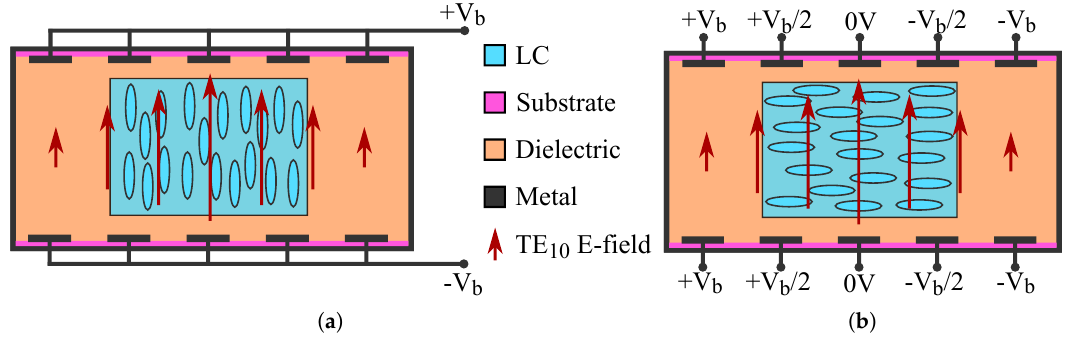
Figure 4. Cross section of an LC waveguide phase shifter, as presented in [16,17]. The waveguide is filled with a dielectric which is utilized as an LC cavity. For electric LC orientation, an electrode system is integrated on a thin substrate inside the waveguide. ( a , b ) show the bias configuration for parallel and orthogonal LC biasing,